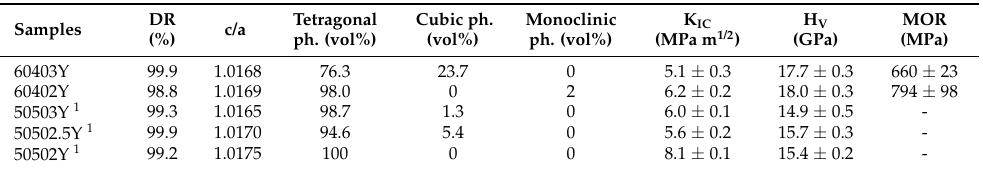
Table 3. Properties of ZTA materials doped with different amounts of stabilizer. DR is the relative density, c/a is the tetragonality, K IC the fracture toughness, H V the microhardness, and MOR is the four-point flexural strength.